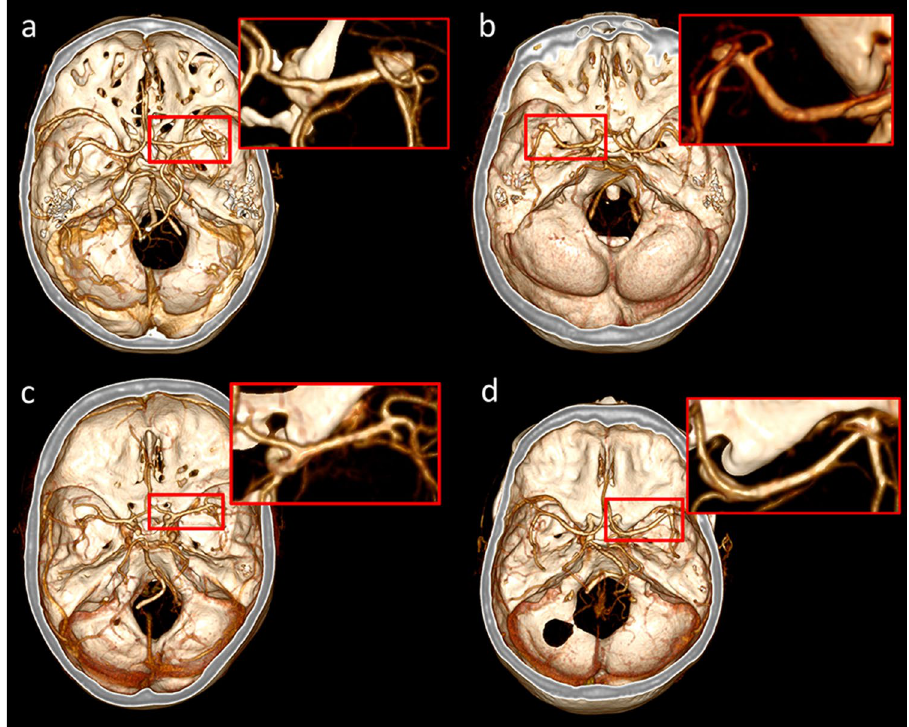
Figure 3. Four confirmed UIAs: ( a ) at the main bifurcation of right MCA (7 mm), ( b ) at the bifurcation of left MCA (3 mm), ( c ) at the M2/3 bifurcation of the right MCA (2 mm), ( d ) at the main bifurcation of right MCA (3 mm).